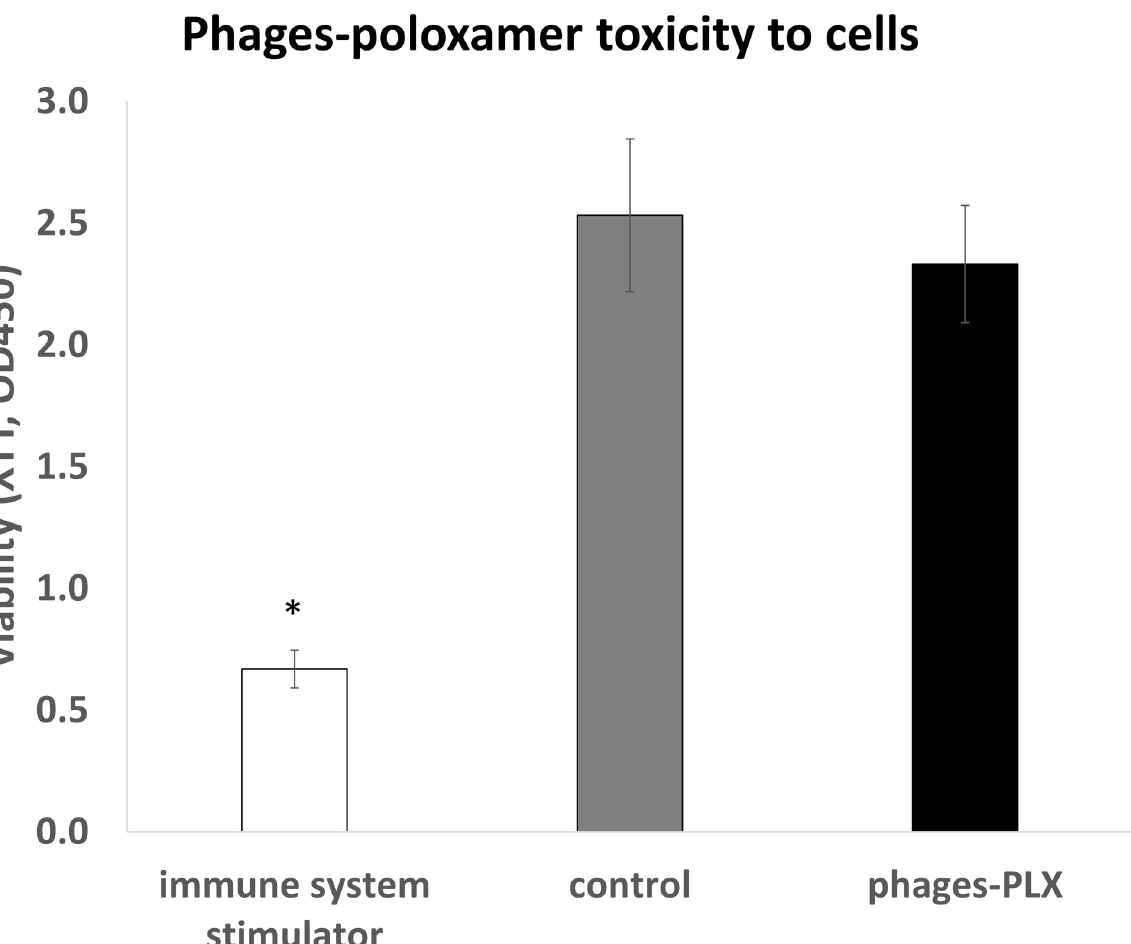
Fig 5. Poloxamer-phage formulation is not toxic to cells. XTT viability indicator shows that RAW macrophage cell viability was unaffected by poloxamer-phage formulation treatment compared to an immune system stimulator (heat killed Pg ). The decrease in the OD 450 of the tested group was insignificant (p > 0.05). White = immune system stimulator, gray = untreated control, black = phages-poloxamer. Statistical significance was calculated by Student’s t-test (significance level: p < 0.05) compared to the untreated control. The results are based on 8 independent biological